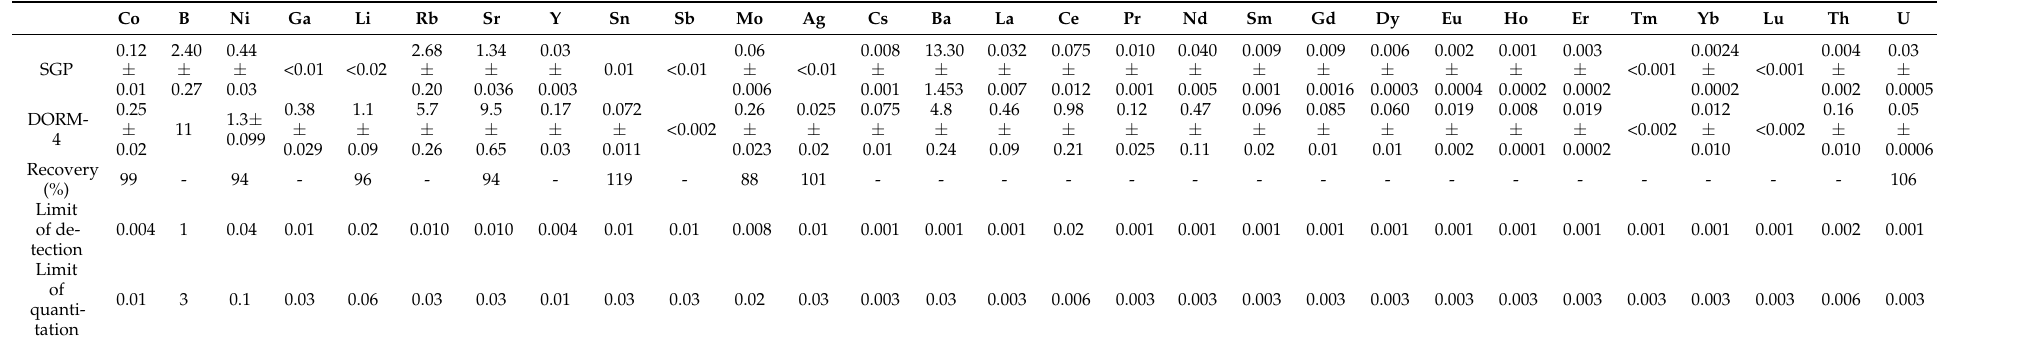
Table 3. Non-essential mineral content of SGP expressed as mg/kg